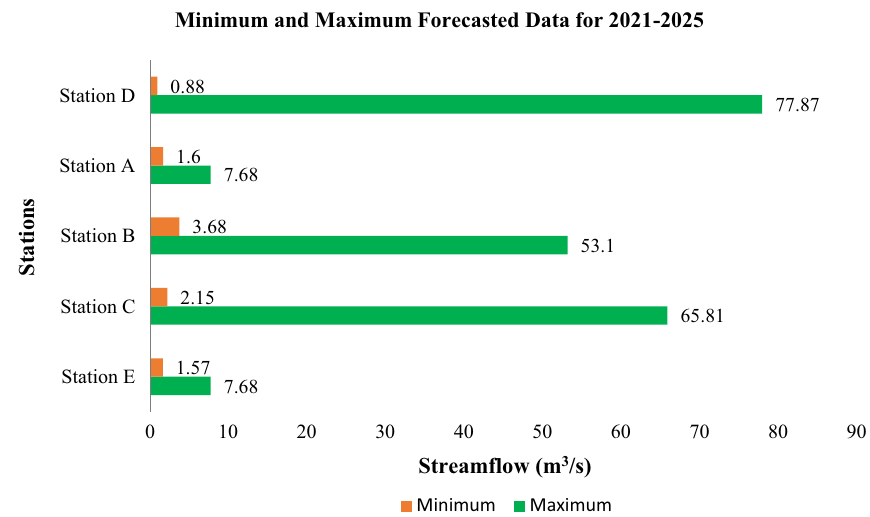
Fig. 7 Minimum and